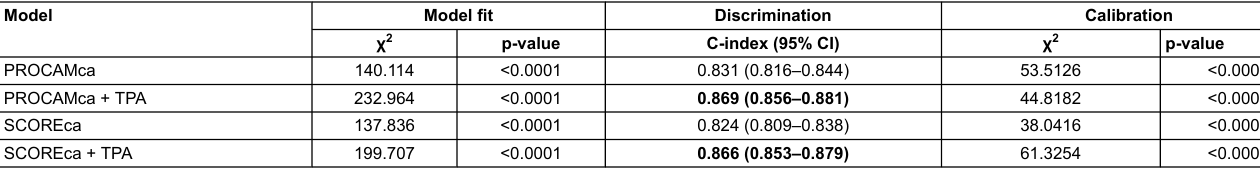
Table 3: Model performance regarding global chi-square, discrimination and calibration. Model